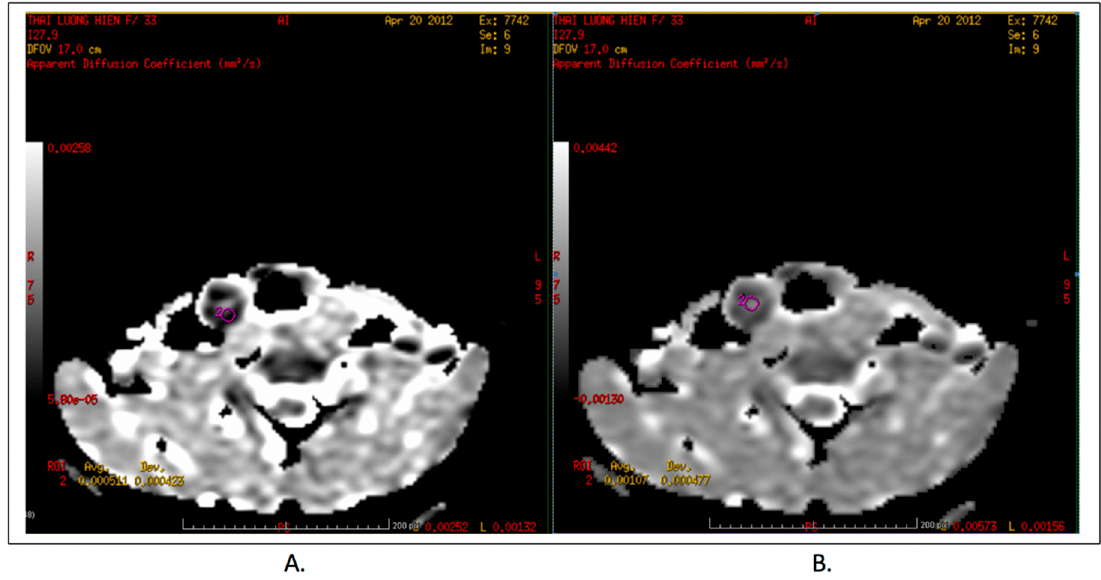
Figure 1. Demonstration on measuring ADC values accurately: ( A ) Right method. ( B ) Wrong method.